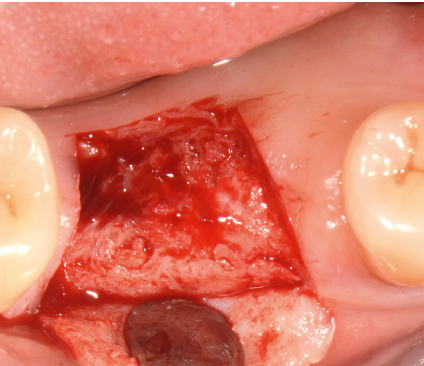
Figure 6: Clinical reentry after 12 weeks of healing. The site is occupied by newly formed hard tissue.